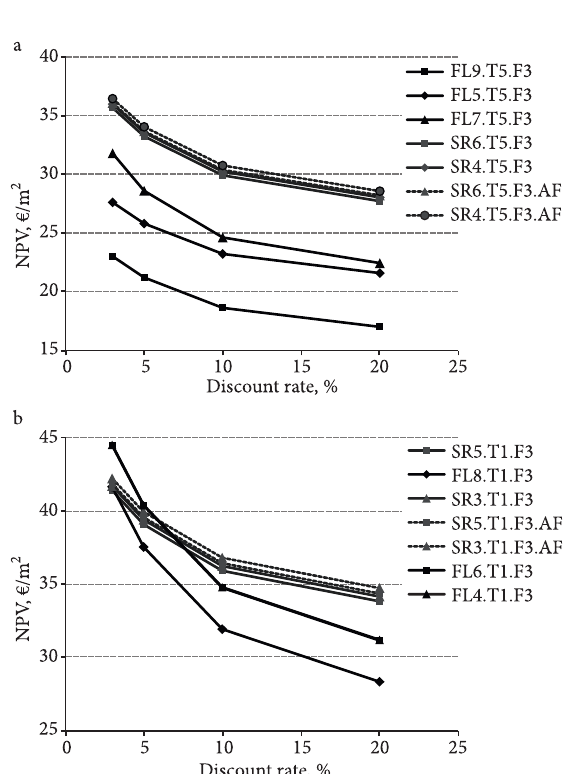
Fig. 3. Sensitivity analysis of the total NPV in relation to the discount rate: a – traffic T5; b – traffic